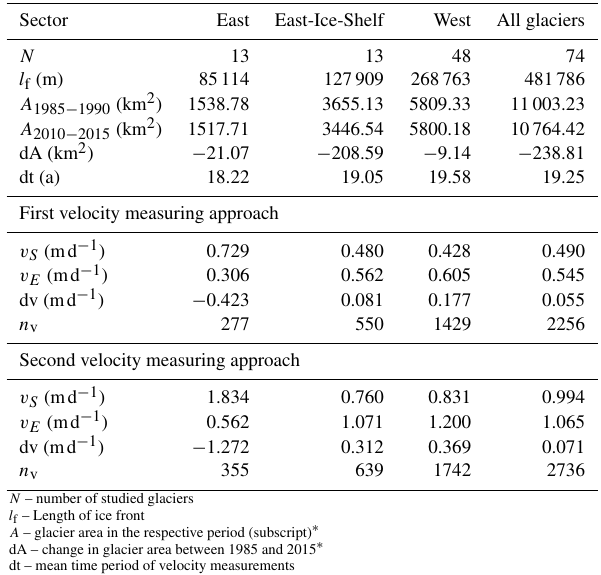
Table 5. Summary of observed parameters for each sector and all